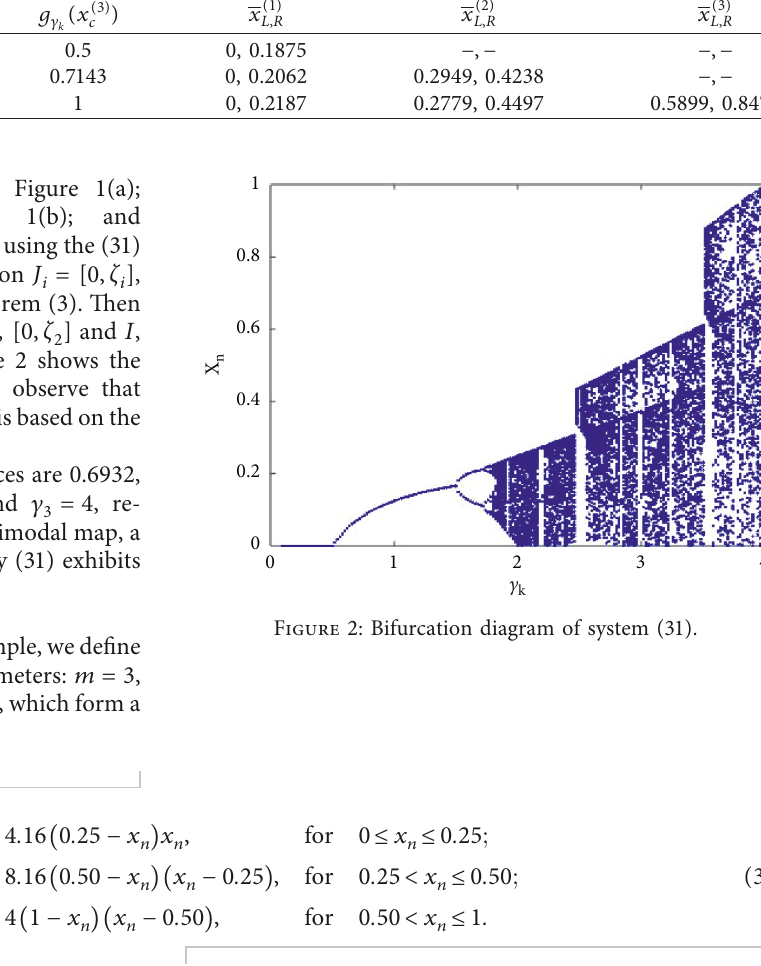
Figure 1: Cobweb diagram of the maps: (a) g � 0 . 05 which a long evolution covers completely the intervals I , [ 0 , ζ equation (31) with x 0 Table 1: Maximum values and fixed points of the multimodal family g